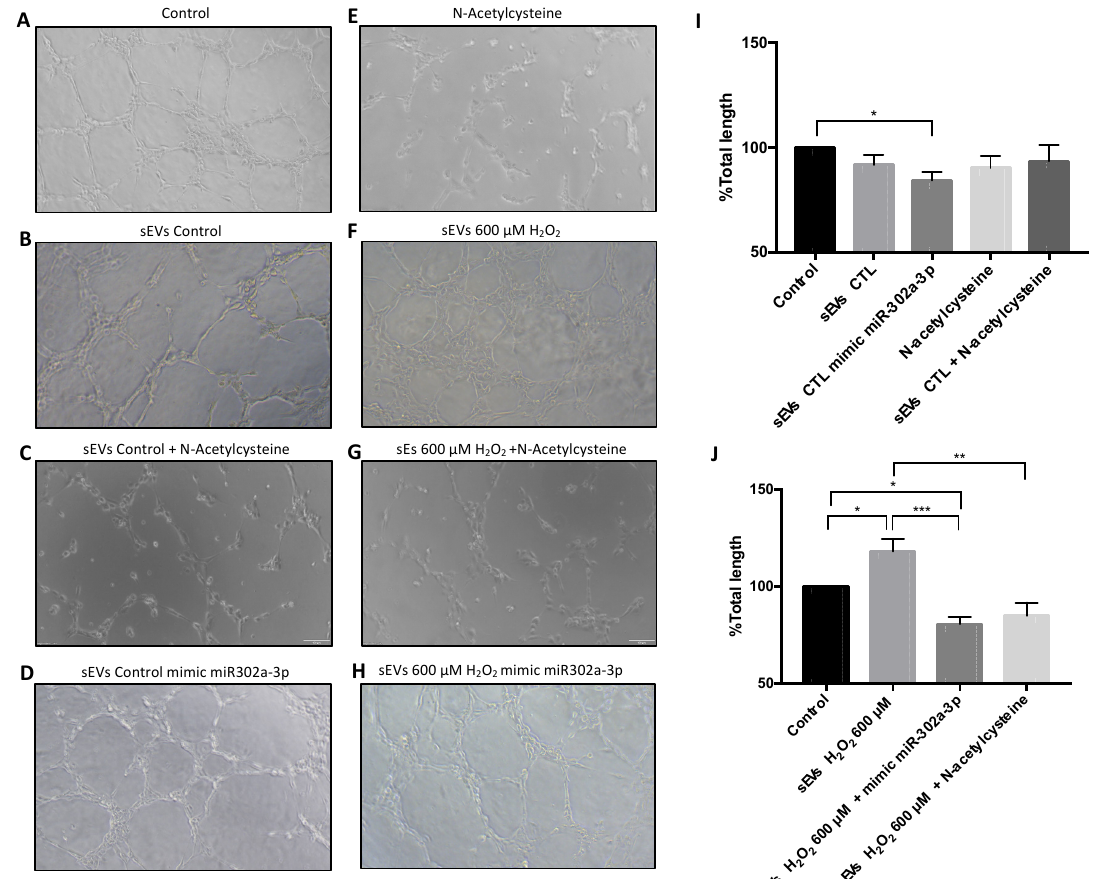
Figure 6. Angiogenesis was mediated by miR-302a-3p within sEVs. HUVEC tube formation subject to different sEVs released by ARPE-19 cell under different conditions. Control medium (100 ± 0) ( A ), sEVs released in control conditions (91,76 ± 4.5) ( B ), sEVs released in control conditions and N-acetylcysteine (93.44 ± 7.69) ( C ), sEVs released in control conditions with mimic miR-302a-3p (84.27 ± 4.15) ( D ), N-acetylcysteine (90.30 ± 5.61) ( E ), sEVs released in H 2 O 2 600 µM conditions (118 ± 6.43) ( F ), sEVs released in H 2 O 2 600 µM conditions and N-acetylcysteine (84.88 ± 6.79) ( G ), and sEVs released in H 2 O 2 600 µM conditions with mimic miR-302a-3p (80.57 ± 3.52) ( H ). Total length ( I , J ) was calculated. Values are expressed as mean ± SEM ( n = 3). The p -value was calculated by ANOVA; * p < 0.05, ** p < 0.01, and *** p < 0.001.